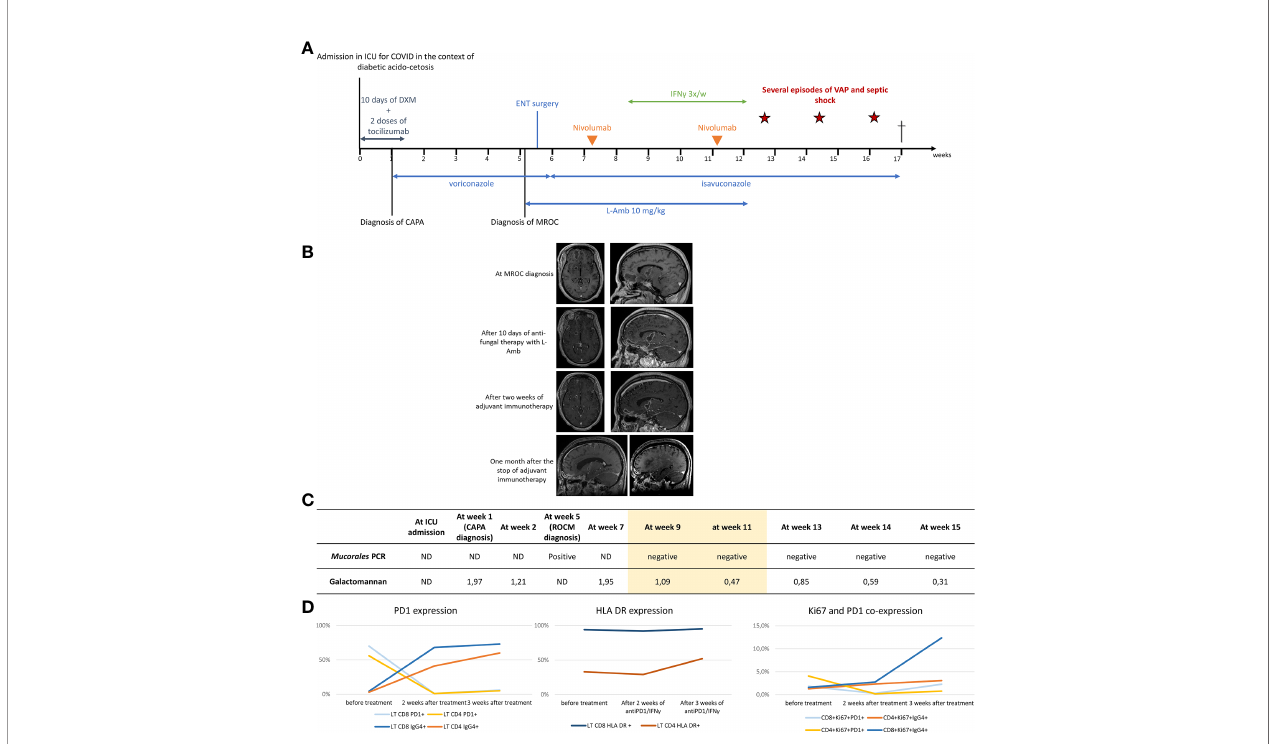
FIGURE 1 | Clinical, radiological and microbiological evolution under treatment. (A) Timeline. The cross indicates the death of the patient. (B) Evolution of cerebral MRI under treatment. Frontal abscess: 35x15 mm at diagnosis, 32,9 mm immediately after surgical drainage (not shown) 30 x 13 mm after 10 days of antifungal therapy with L-Amb, 24 x 42 mm after two weeks of adjuvant immunotherapy, 14 x 9 mm one week after the stop of adjuvant immunotherapy (not shown) and 9 x 7.2 one month after the stop of adjuvant immunotherapy. lenticulo-capsular abscess: 28 x 14 mm at diagnosis 28 x 17 mm after 10 days of antifungal therapy with L-Amb 24 x 14 mm after two weeks of adjuvant immunotherapy, 17 x 11.5 mm one week after the stop of adjuvant immunotherapy (not shown) and 9.5x7 mm one month after the stop of adjuvant immunotherapy. One morth after the stop of adjuvant immunotherapy, the two initial abscesses had reduced in size. However, shown in the bottom right MRI image, several new cerebral abscesses had appeared. (C) Evolution of seric GM and Mucorales PCR under treatment. The yellow color underlines the time under immunotherapy. (D) Evolution of PD-1, HLA-DR and Ki67 expression on circulating LT CD4+ and LT CD8+ under treatment. Expression of PD-1,HLA-DR and Ki67 were measured before treatment with nivolumab and 2 and 3 weeks after immunotherapy initiation. After nivolumab injection, PD-1 expression is less, detected as T cells are covered by the anti-PD1 antibody. Cells covered with nivolumab were identi fi ed using an anti-IgG4 detection approach. Ki67 has been identi fi ed a maker of cellular proliferation and T-cell reinvigoration upon checkpoint blockade (1) As shown in the right graft, the increase in Ki67 expression was most prominent in the IgG4+ versus PD-1+ CD8 and CD4 T celle, i.e., in T cell covered with